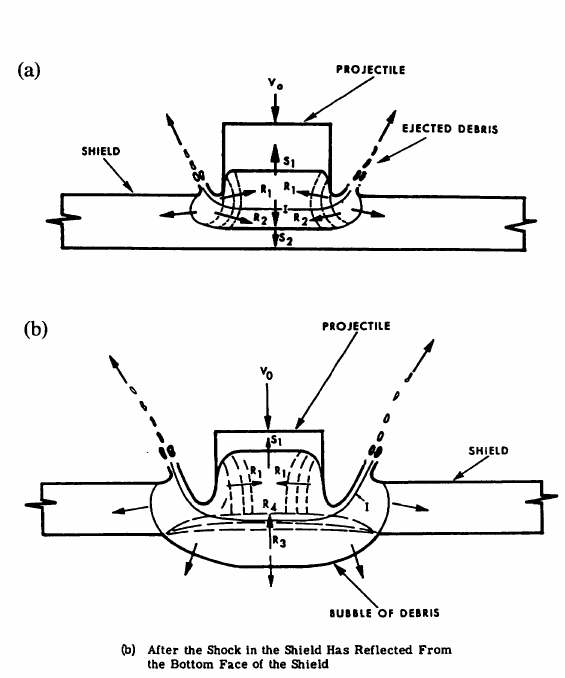
FIGURE 1 Wave patterns in a projectile and an im pacted target (Maiden et al.,